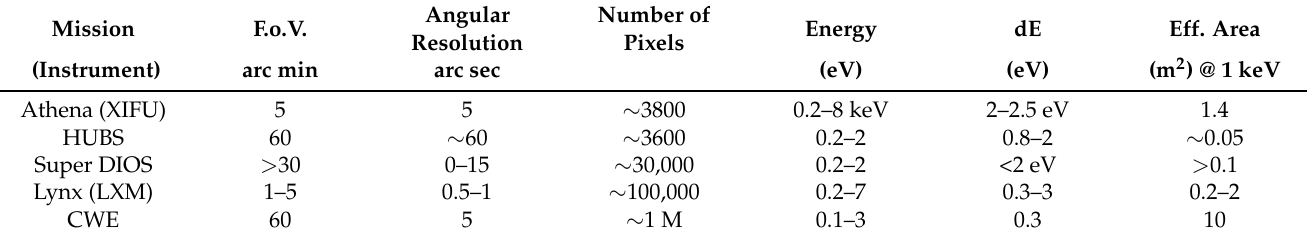
Table 1. Overview of the characteristic of the TES-based instruments planned for the future X-ray space observatories. Athena is currently in the ESA Phase-A study. The other missions are still in the selection or proposal phase. Mission